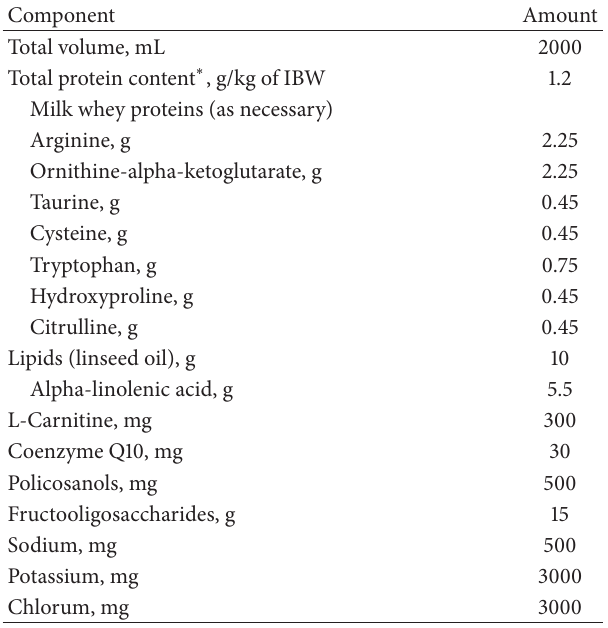
IBW: ideal body weight. ∗ Including amino